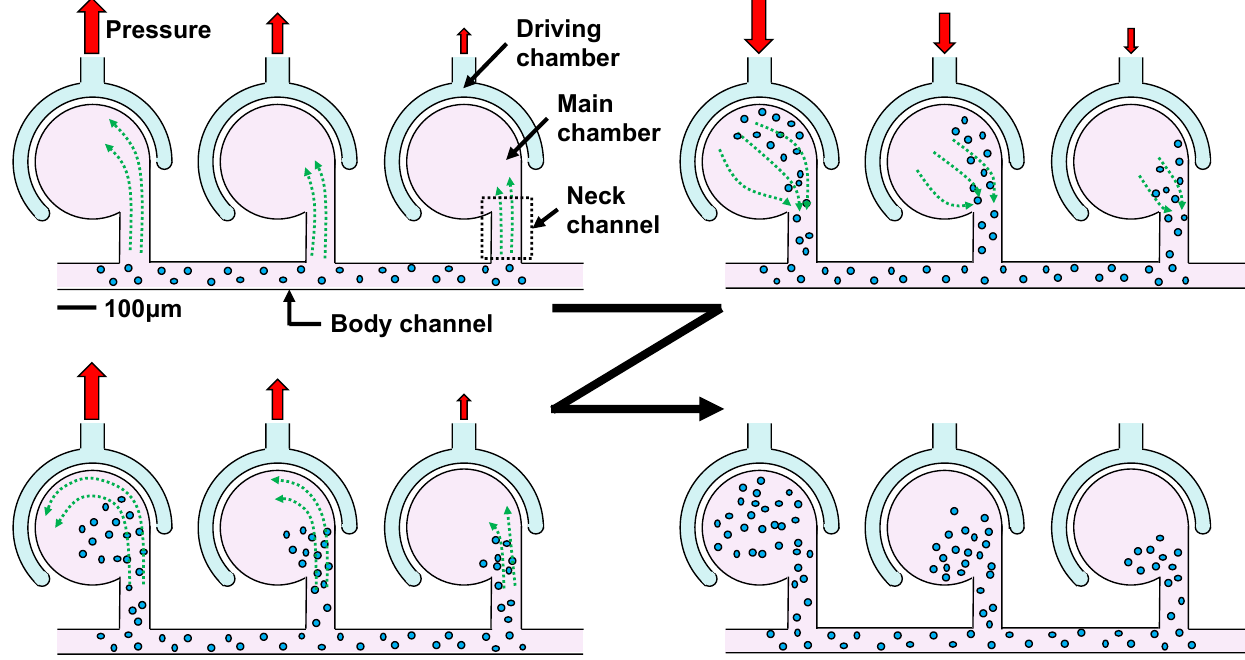
Figure 1. Driving principle of outer-circumference-driven mixer. The liquid in the main channel is gradually siphoned into the main chamber. Mixing speed can be changed by driving